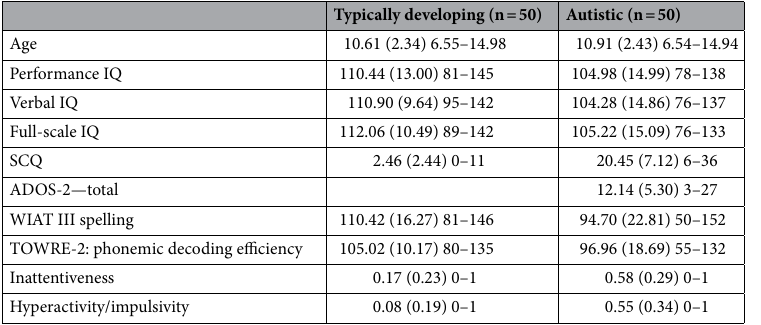
Table 1. Demographics of participants included in final dataset. Data are presented as M (SD) Range. SCQ Social Communication Questionnaire 59 , ADOS-2 Autism Diagnostic observation schedule, 2nd Edition 60 , WIAT-III Wechsler Individual Achievement Test, 3rd Edition 63 , TOWRE-2 Test of Word Reading Efficiency, 2nd edition 62 . Standard scores are presented for the WIAT-III and TOWRE-2. Average item scores are presented for the Inattentiveness and Hyperactivity/impulsivity